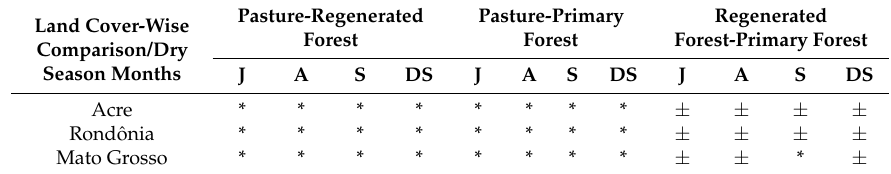
Table 6. A summary of the statistical comparison of monthly and dry season ET from different land cover types within each study site for July (J), August (A), and September